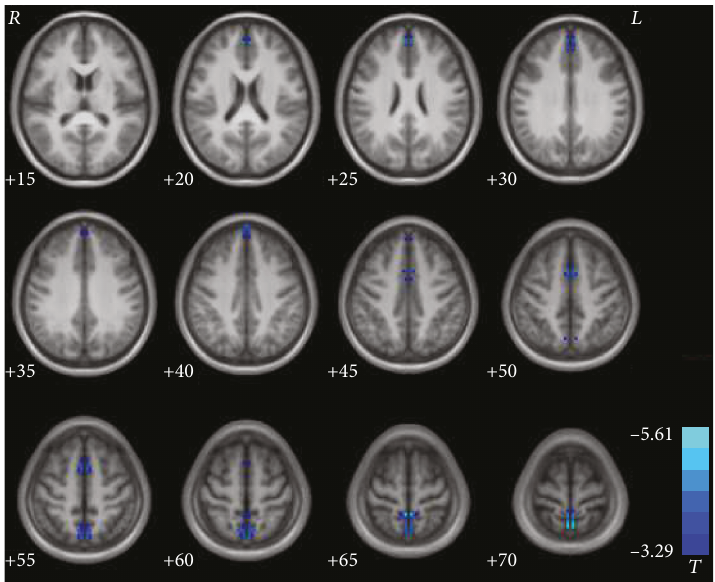
Figure 1: Statistical maps showing VMHC di ff erences between patients and healthy controls. Blue denotes lower VMHC values, and the color bar indicates T values from t -tests between groups ( P < 0 05 , GRF corrected). VMHC=voxel-mirrored homotopic